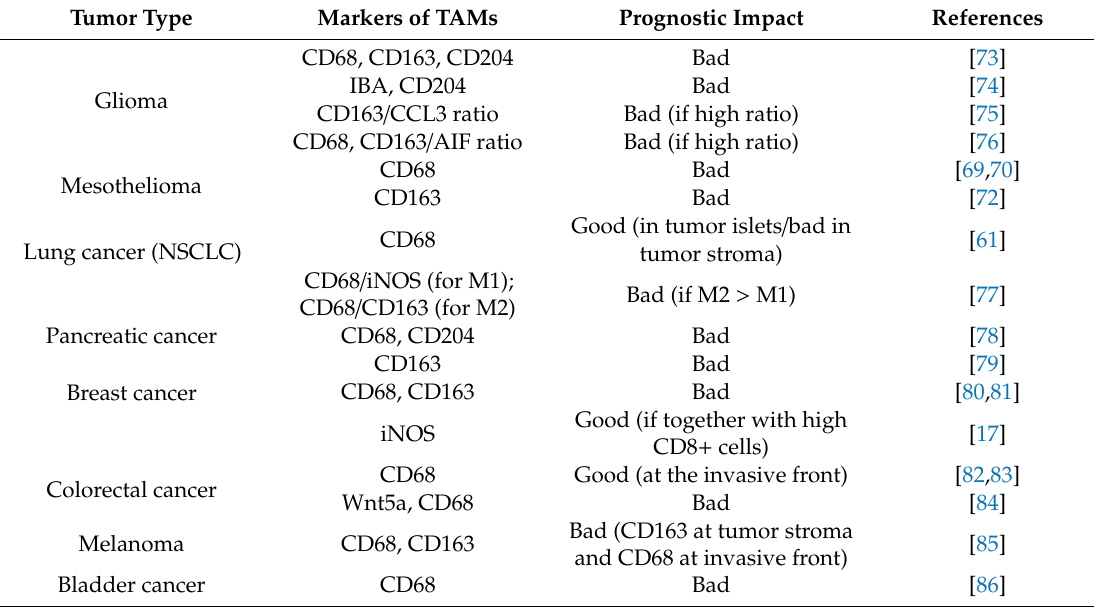
Table 1. Prognostic significance of TAMs and relevant markers in di ff erent human tumor types. Tumor